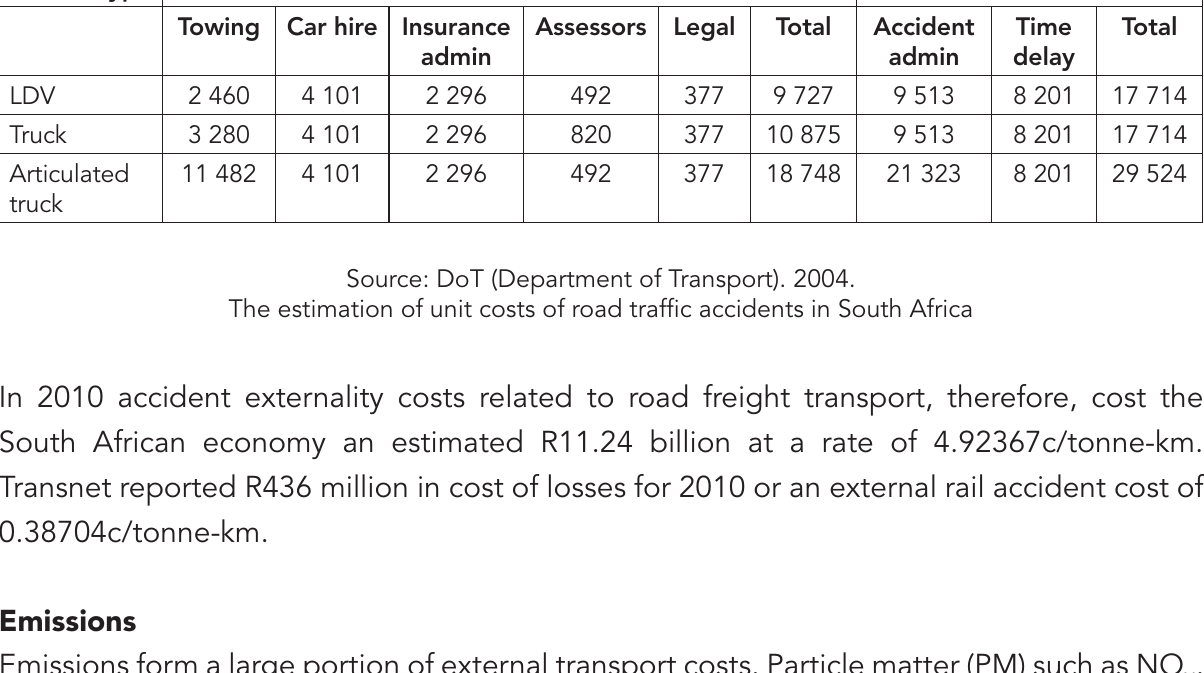
Table 1: Additional external costs incurred per vehicle and per accident, 2004 values adjusted to 2010 for CPI inflation (rand per vehicle) Vehicle type Per